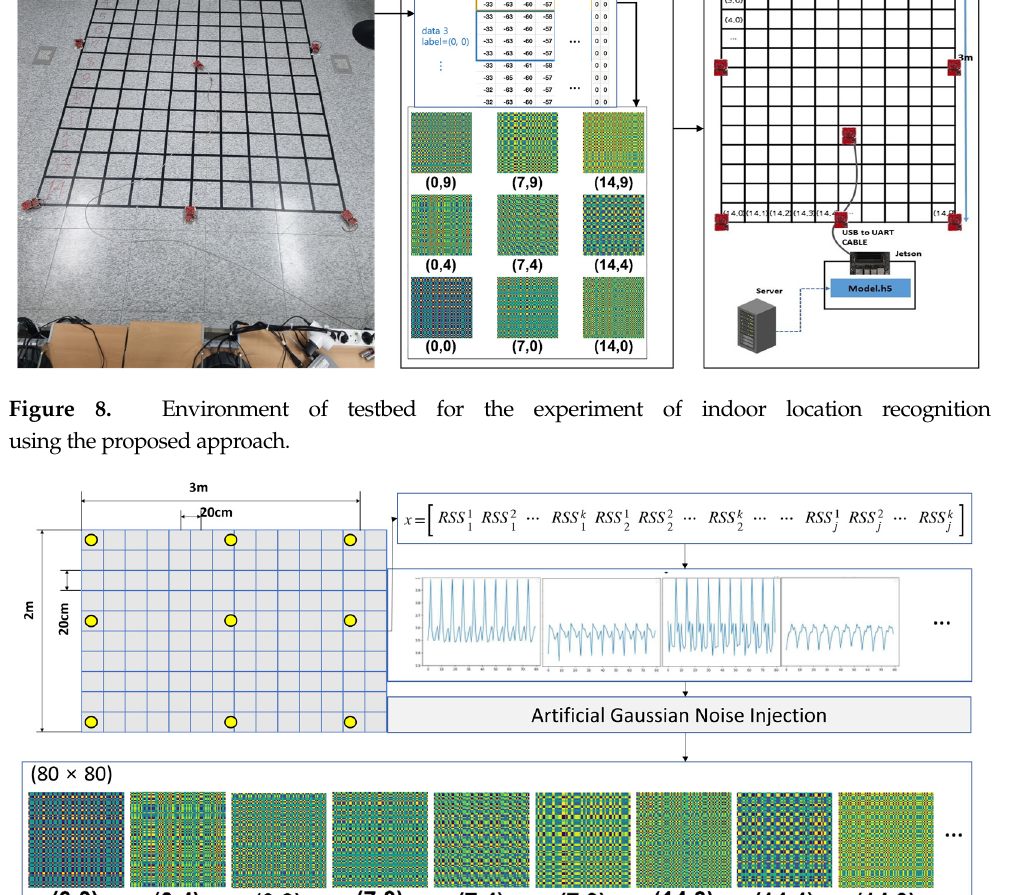
Figure 8. Environment of testbed for the experiment of indoor location recognition using the pro- posed approach.